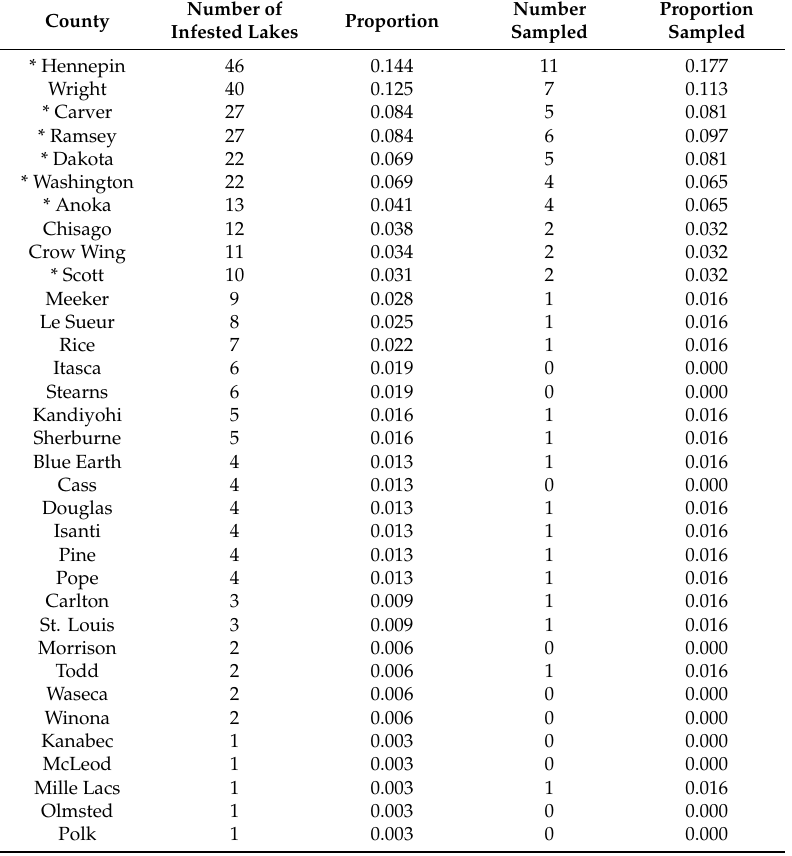
Table A1. Eurasian watermilfoil recorded infested lake counts by county out of 87 total Minnesota counties as of 2017, proportion of statewide occurrences, and number of lakes we sampled.